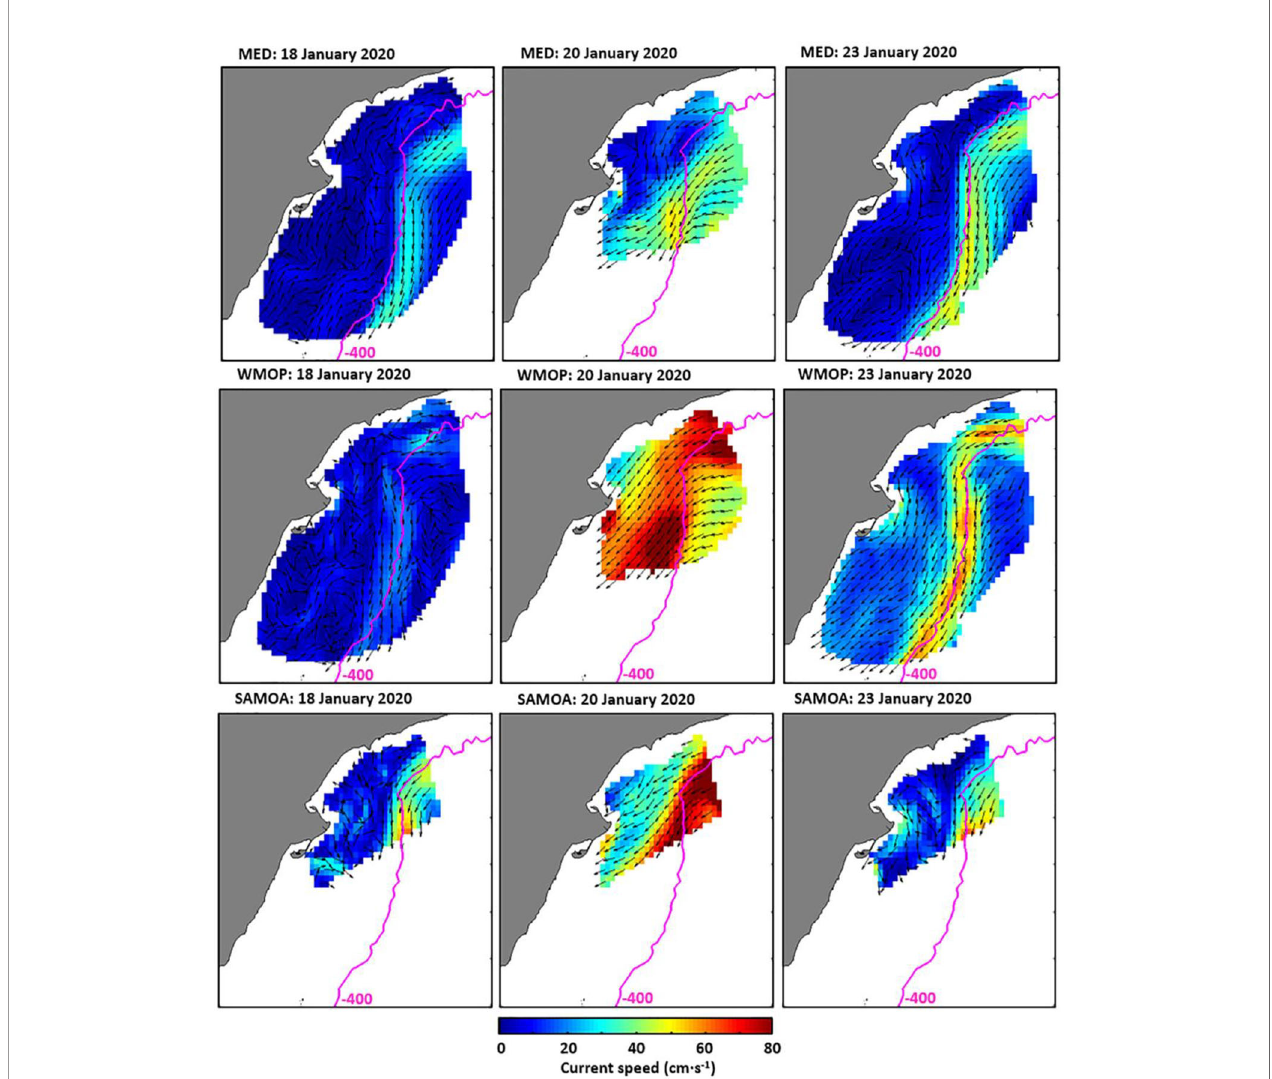
FIGURE 1 | Model validation with HF radars observations: currents at the Ebro delta observed by the HF radar (1st row) and simulated by GLO (2nd row), MED (3rd row), IBI (4th row), WMOP (5th row) and SAMOA (6th row), on the 19th (1st column), 20th (2nd column), and 21st (3rd column) of January.